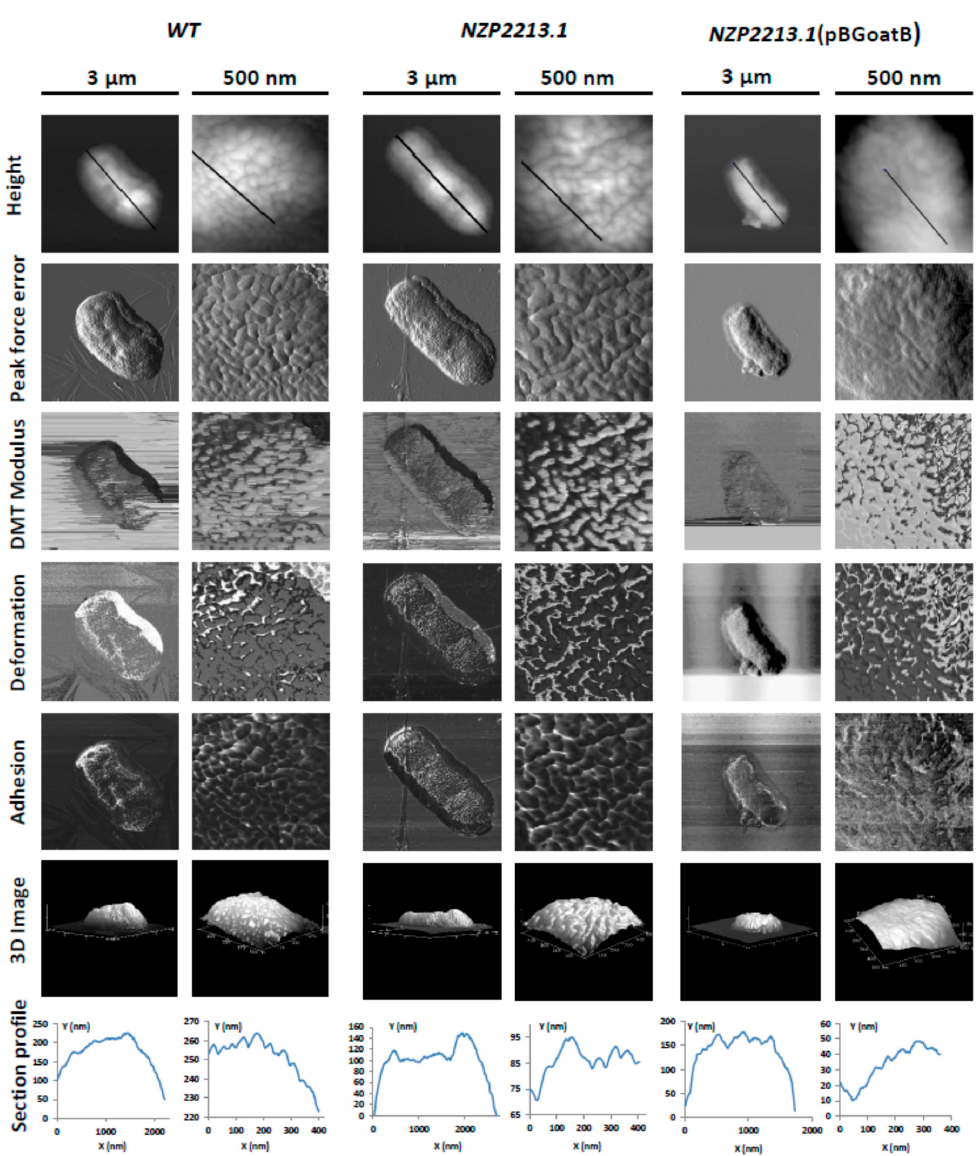
Figure 4. Atomic force microscopy (AFM) images of wild-type Mesorhizobium loti NZP2213 (WT), the NZP2213.1 mutant, and the complemented NZP2213.1(pBGoatB) strain. The columns show air-dried whole cells (3 × 3 µm) and surface ultrastructures at a high resolution (500 × 500 nm). Section profiles, presented in the lower panel, correspond to the height profiles (upper panel) obtained along the black scan lines shown in them.